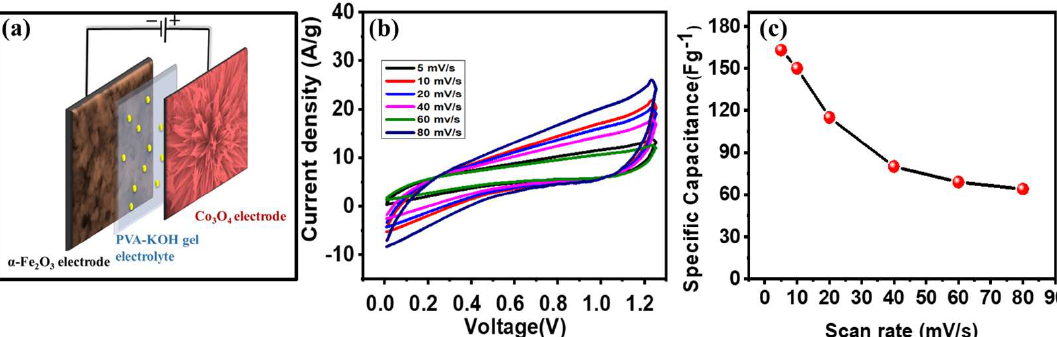
Figure 7. ( a ) Schematic of the supercapacitor device, ( b ) CV curves at different scan rates for the Co 3 O 4 -NF// α -Fe 2 O 3 -NF ASC device, ( c ) variation in specific capacitance at different scan rates for the Co 3 O 4 -NF// α -Fe 2 O 3 -NF ASC device.